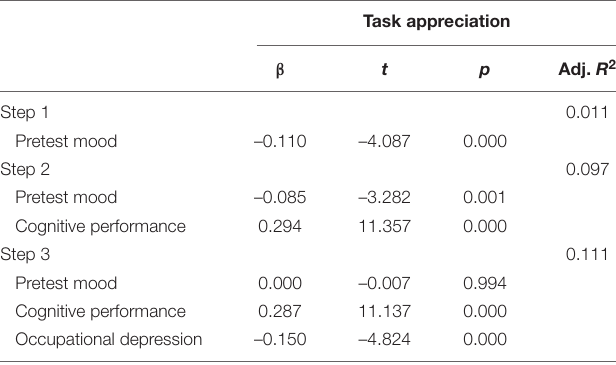
TABLE 4 | Summary of hierarchical linear regression analysis—occupational depression predicting task